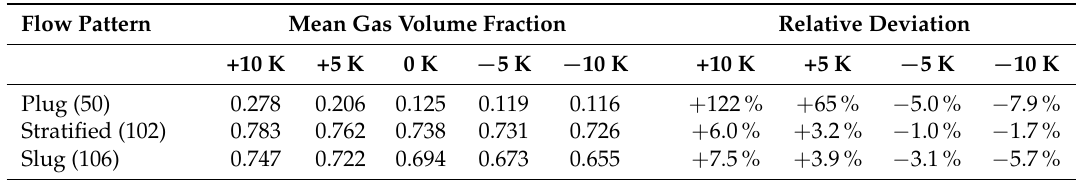
Table 3. Mean gas volume fractions of the analyzed gas-liquid flows and their relative deviations with respect to the temperature difference of the reference measurement Flow Pattern Mean Gas Volume